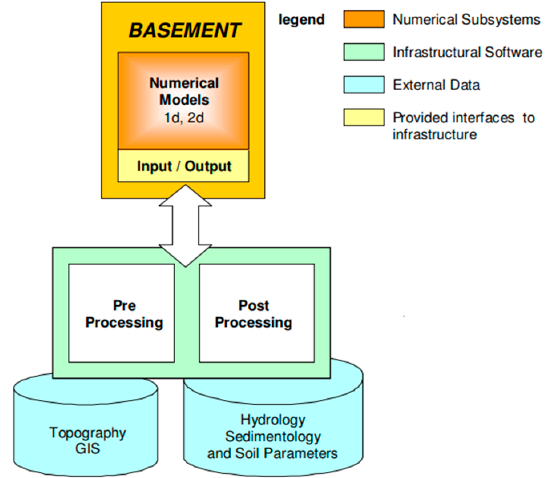
Figure 4. BASEMENT system overview.